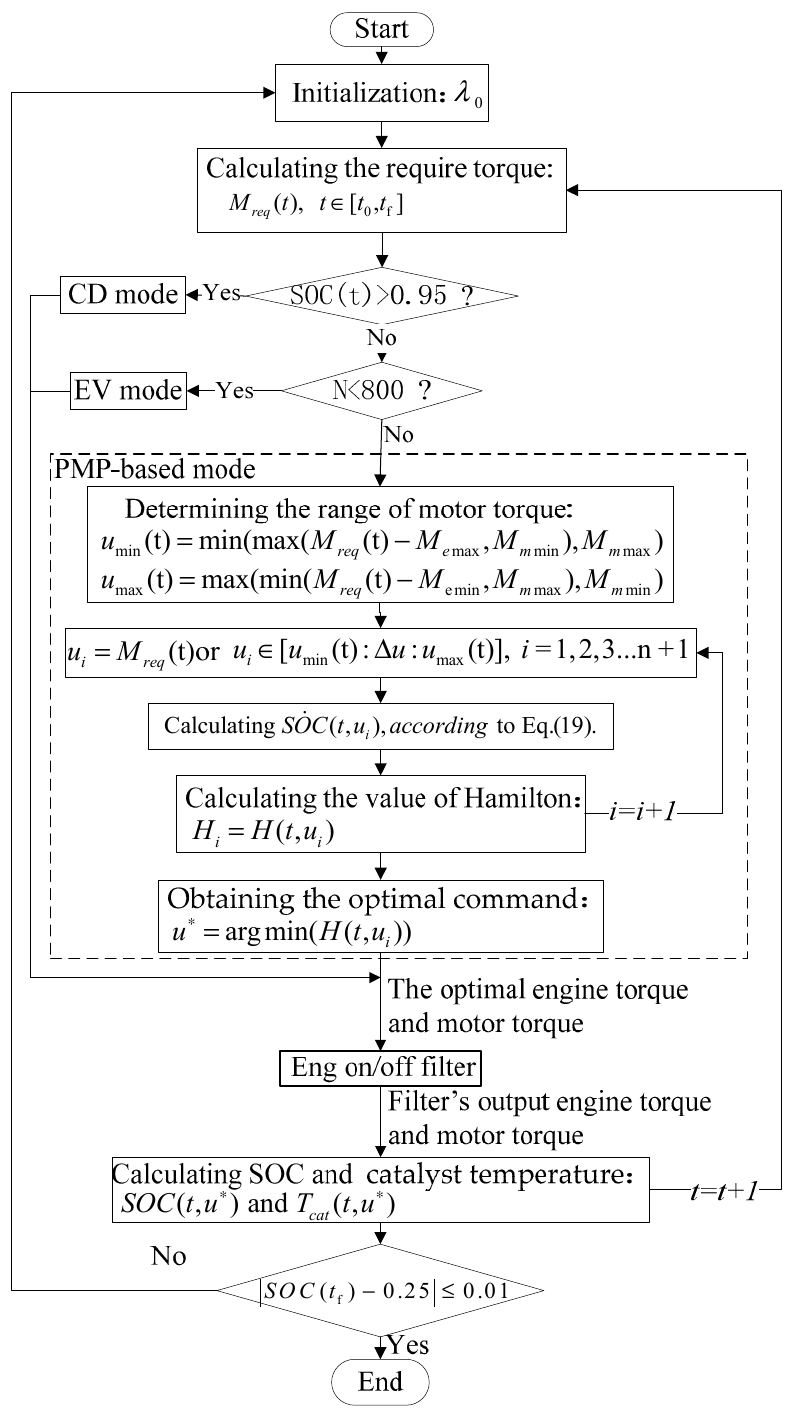
Figure 19. Calculation process of PMP-based EMS with eng on/off filter.